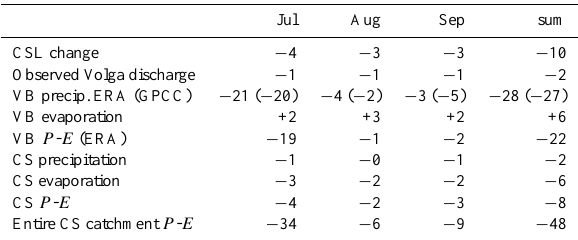
Table 4. Water budget component anomalies for summer 2010. Units: change of the Caspian Sea level in cm. Differences between the sum and single month values might result from rounding. For abbreviations see Table 1.